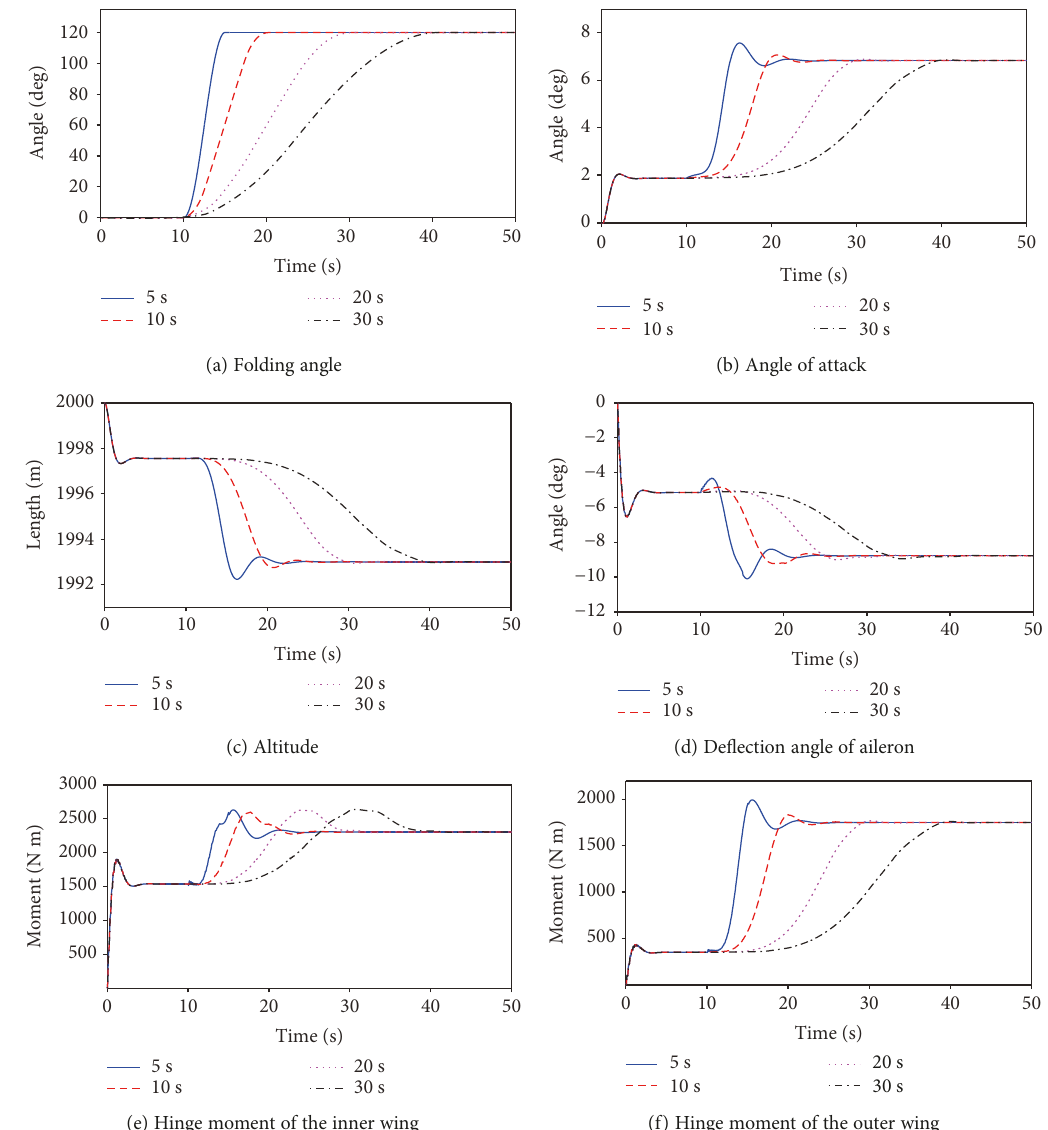
(f) Hinge moment of the outer wing Figure 8: Response at di ff erent folding